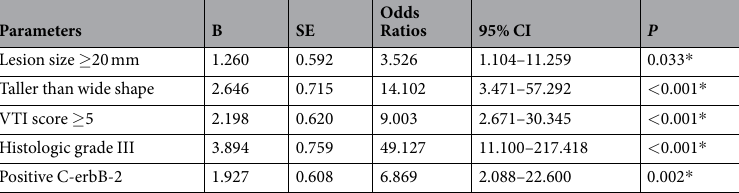
Table 4. Multivariate analysis in predicting axillary lymph node metastasis. VTI virtual touch tissue imaging, SE standard error, CI confidence interval. * Indicates statistically significant